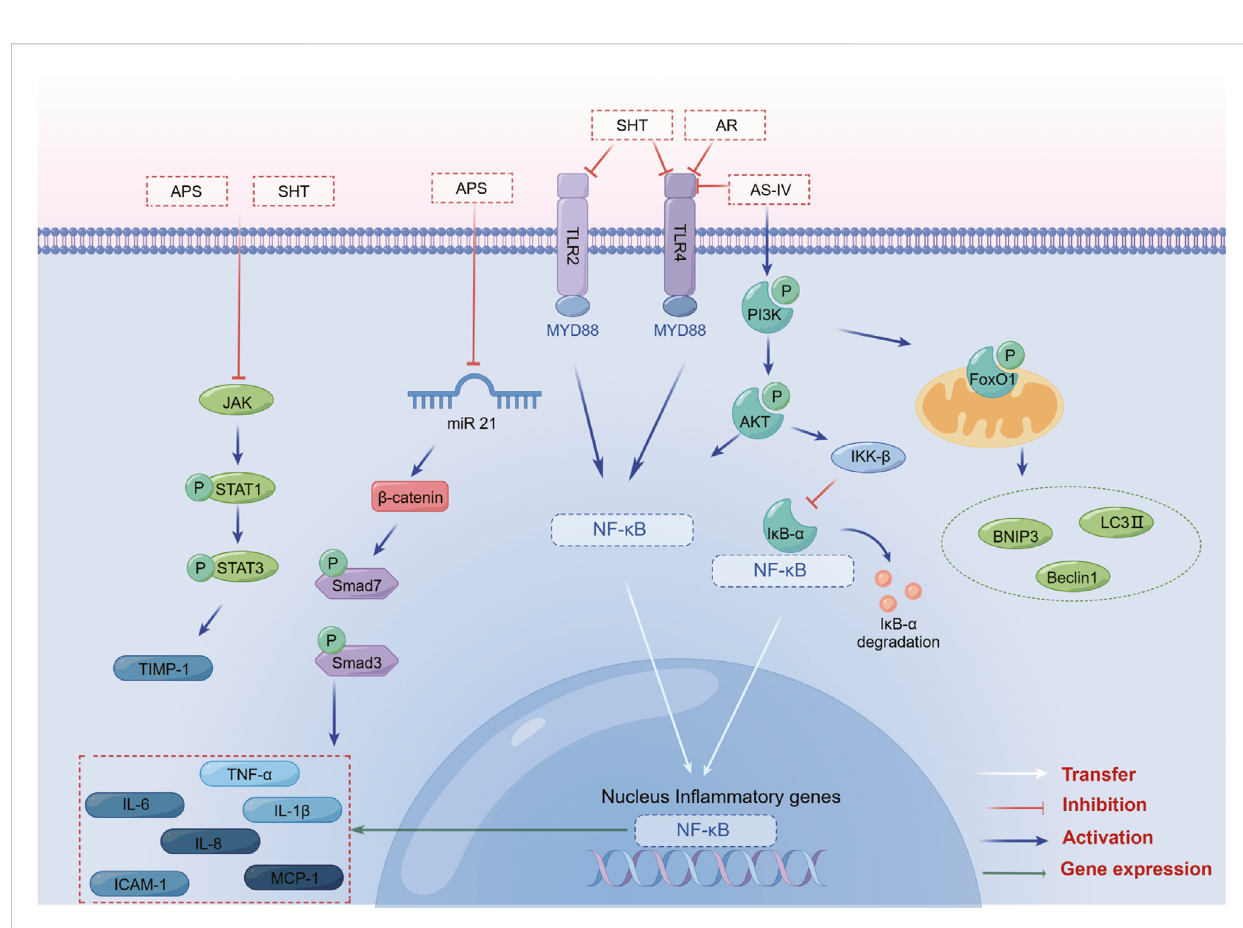
FIGURE 3 SHT, AR and AS-IV inhibit in fl ammation through the NF- κ B, TLR, PI3K/AKT, Wnt/ β -catenin, and JAK-STAT signaling pathways. Note: SHT, Fufang Shenhua tablet; AR, Astragali Radix; AS-IV, Astragaloside IV; APS: Astragalus polysaccharide. By Figdraw.